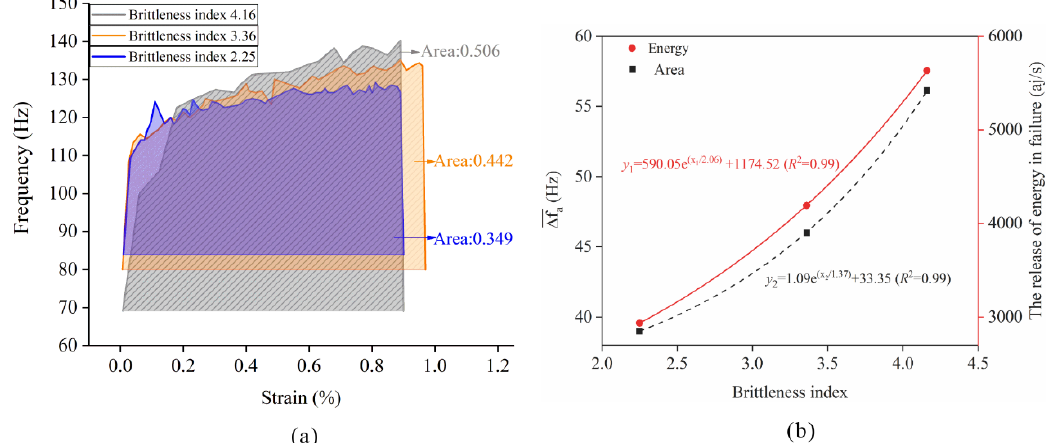
Figure 21. Analysis of the average natural frequency increment and energy: ( a ) area formed by the natural frequency curve and the strain at peak strength of specimens with different brittleness indexes; and ( b ) relationship between ∆ f a , energy and the brittleness index.